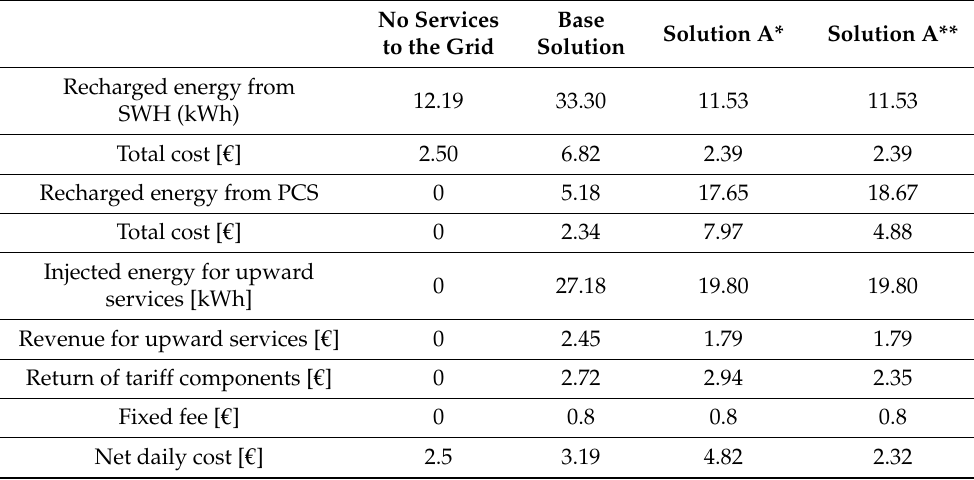
Table 23. Results for mobility pattern1—UVAMbis (Scenario B).